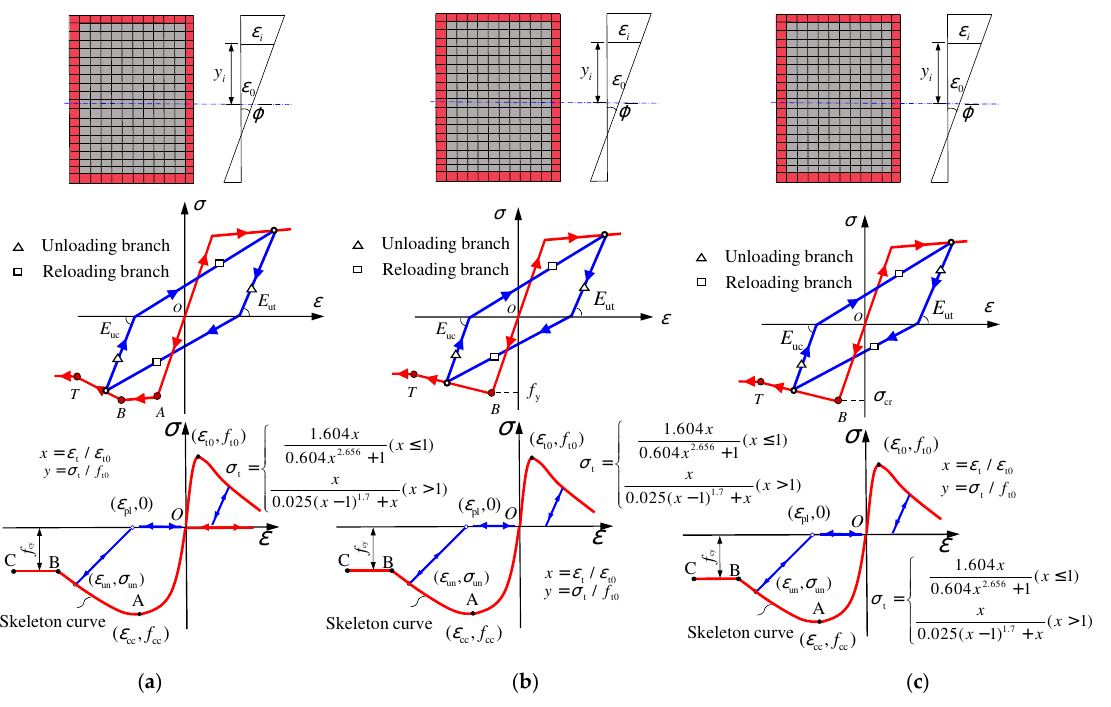
Figure 3. The fiber model considering local buckling. ( a ) Small b / t ( b ) Medium b / t ( c ) Large b / t.